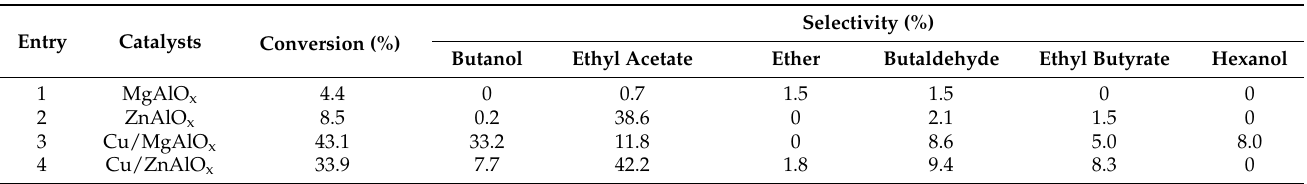
Table 1. Catalytic activities of mixed oxides and supported Cu catalysts for ethanol conversion.